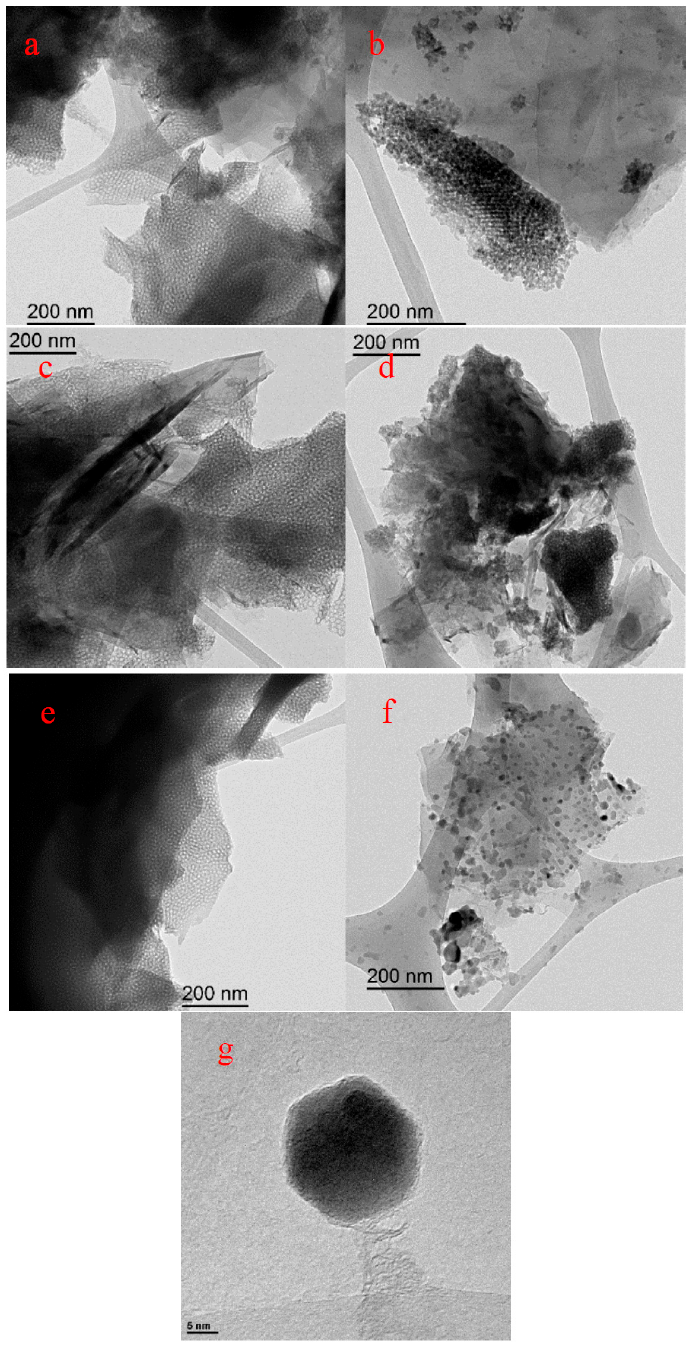
Figure 3. TEM images of ( a ) G / Si, ( b ) G / Ti, ( c ) G / Si_PANI_5min, ( d ) G / Ti_PANI_5min, ( e ) G / Si_PANI_5min_900, ( f ) G / Ti_PANI_5min_900, and ( g ) high resolution of G /